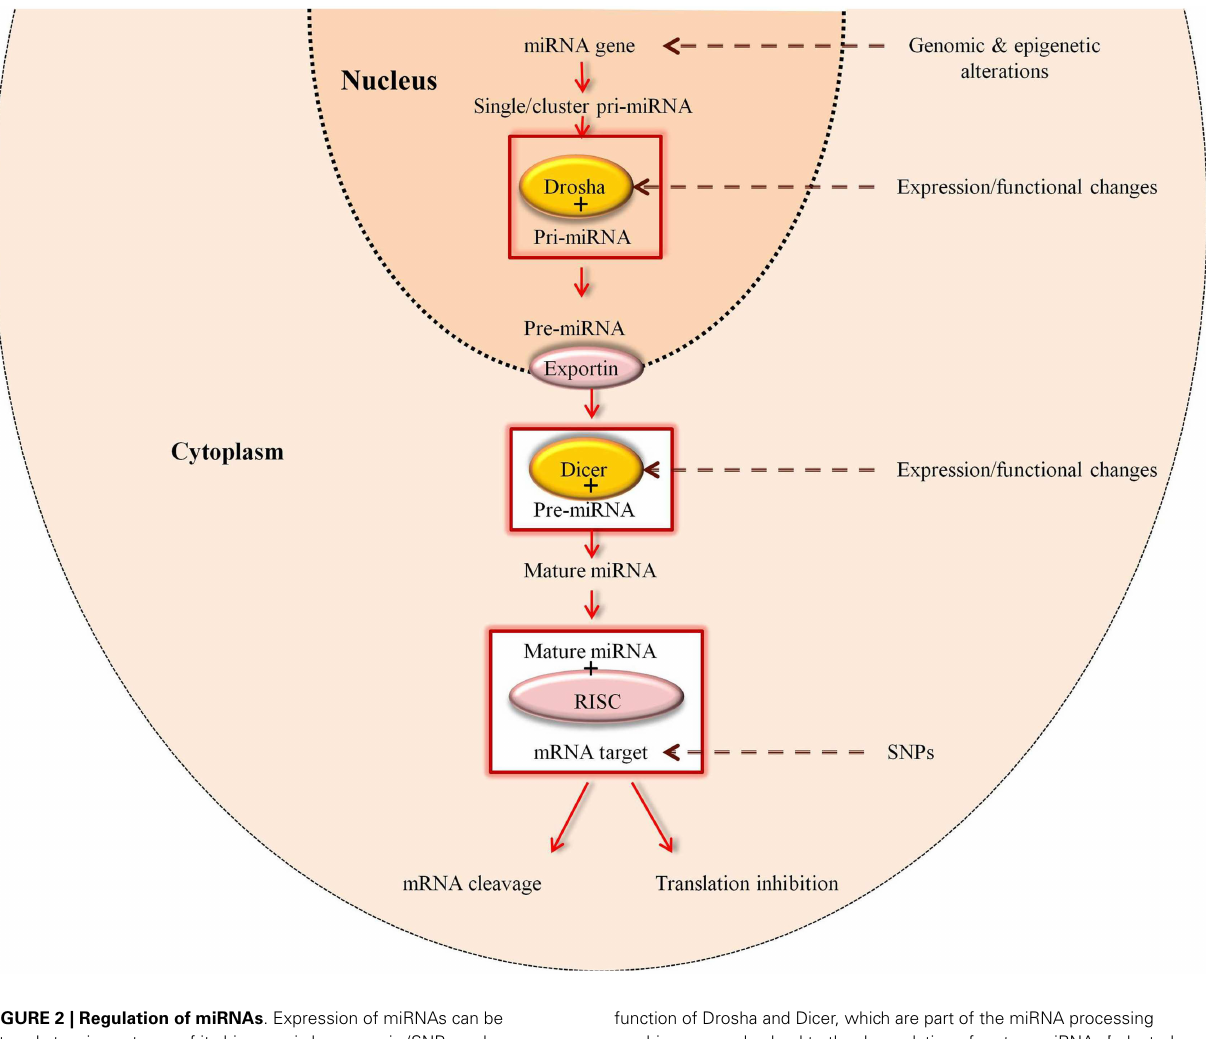
function of Drosha and Dicer, which are part of the miRNA processing machinery, can also lead to the deregulation of mature miRNAs [adapted from Ref.